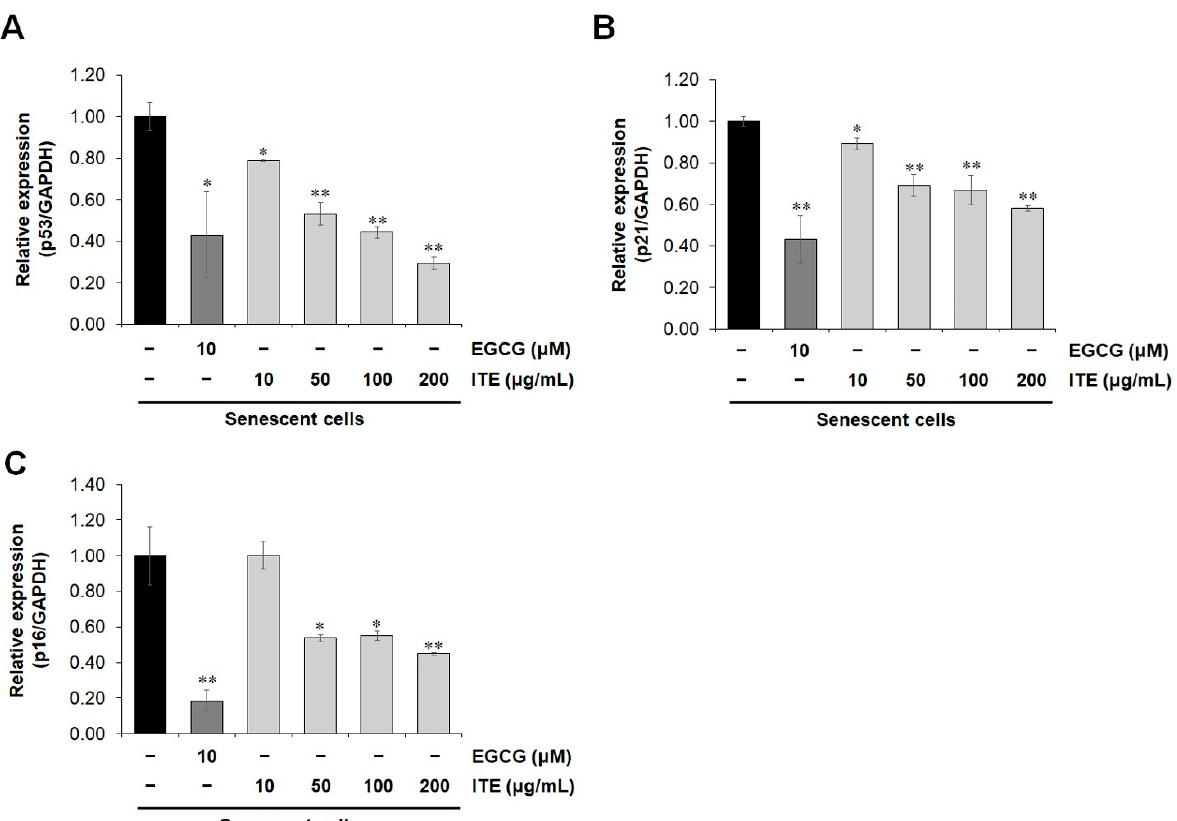
Figure 2. Inhibitory effect of ITE on tumor suppressors in RS-HDFs. qRT–PCR for p53 ( A ), p21 CIP1 ( B ), p16 INK4A ( C ) mRNA expression. The data are presented as the mean ± SEM of three independent assays. * p < 0.05; ** p < 0.01 compared to RS-HDF control.